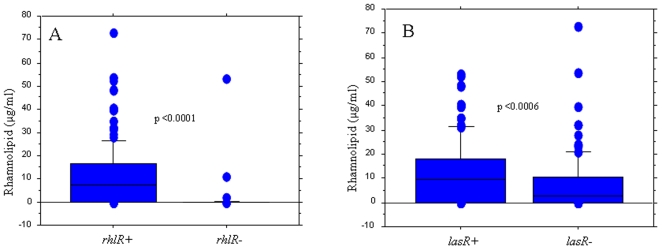
Distribution of rhamnolipid production in isolates with or without mutations in the QS regulatory genes.Box and whisker plots represent the median (thick line inside the box), 10, 25, 75 and 90 centiles of the in vitro rhamnolipid production (µg/ml) of P. aeruginosa isolates (A) with (rhlR−) or without mutations (rhlR+) in the regulatory gene rhlR; (B) with (lasR−) or without mutations (lasR+) in the regulatory gene lasR Mann-Whitney test was used to investigate the significance of the difference between the groups.